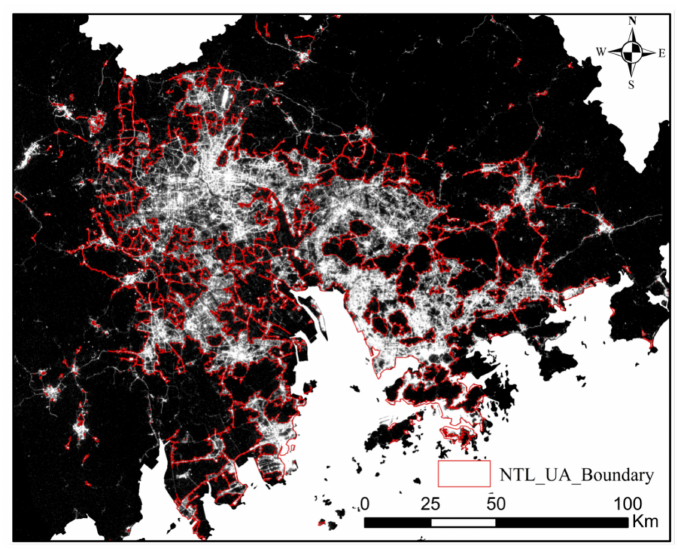
Figure 6. Urban agglomeration boundaries delineated by NTL.